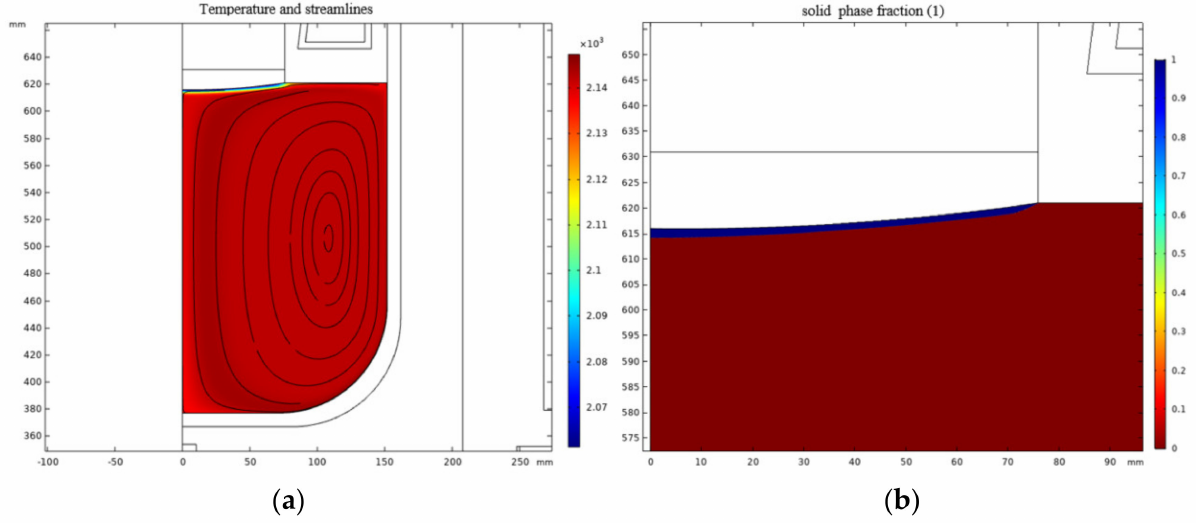
Figure 3. ( a ) The temperature and velocity field; ( b ) the solid–liquid